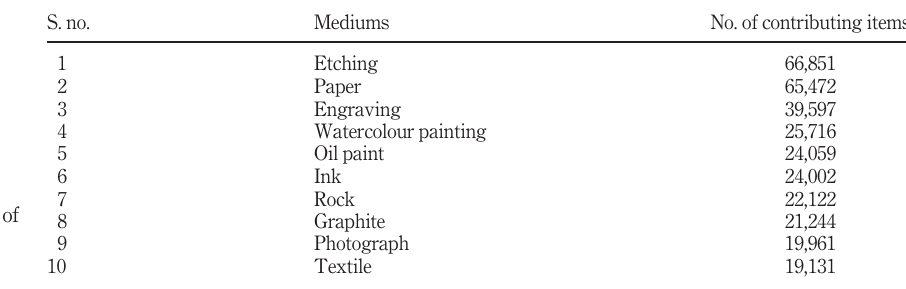
Table III. Top ten artists of Google Art and Culture